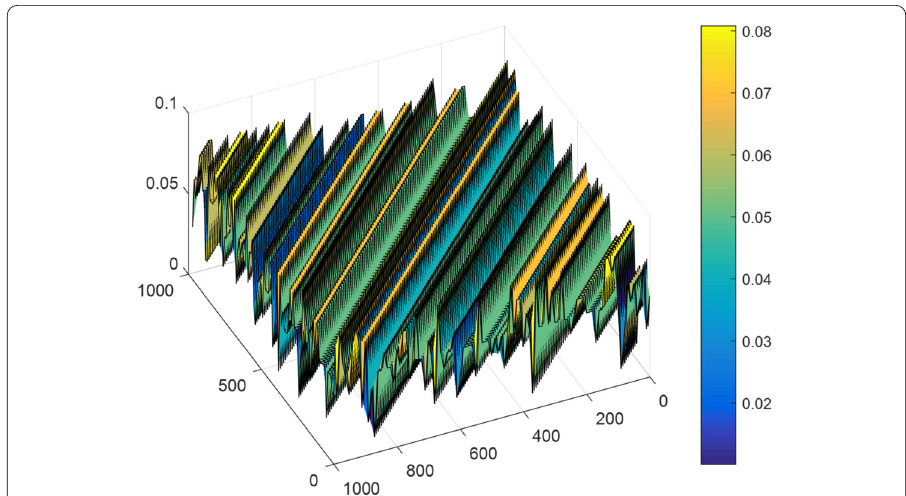
Figure 1 Size properties of FFFFF-FI-ADF % 5 nominal significance